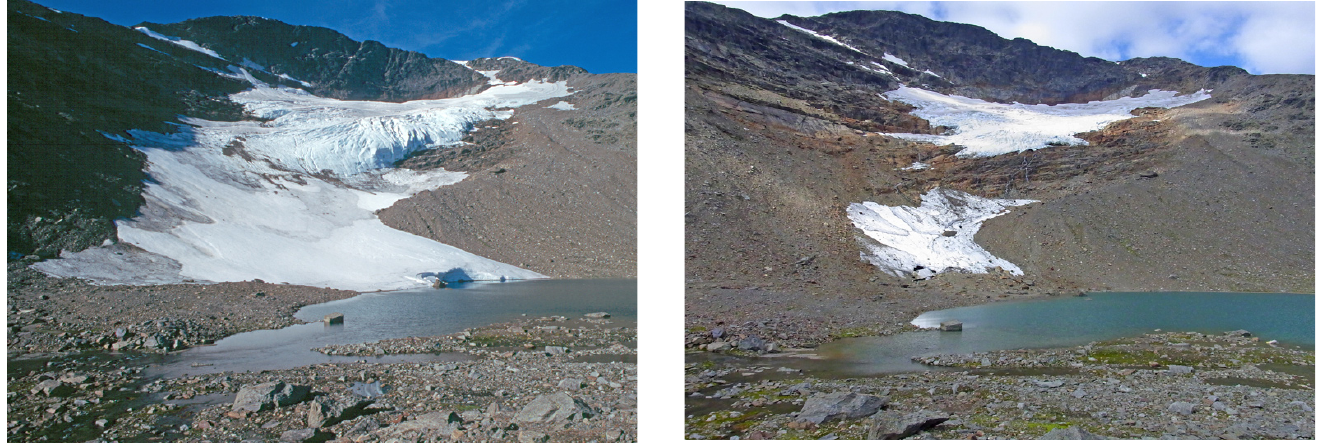
Figure 10: Left. Tärnaglaciären (6) from southeast. The lower glacier front is halfway between the lake and the summit. Below, an extensive snow/ice patch extends virtually down to the lake. Photo: 1999-09-08 (Lindgren & Strömgren 2001). Right. Since 1999, the glacier and the snow/ice patch have receded and thinned substantially.